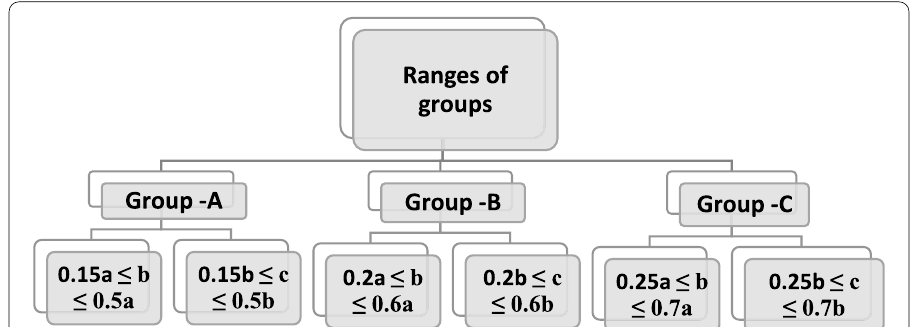
Fig. 5 Proportions of the elements in groups: A, B, and